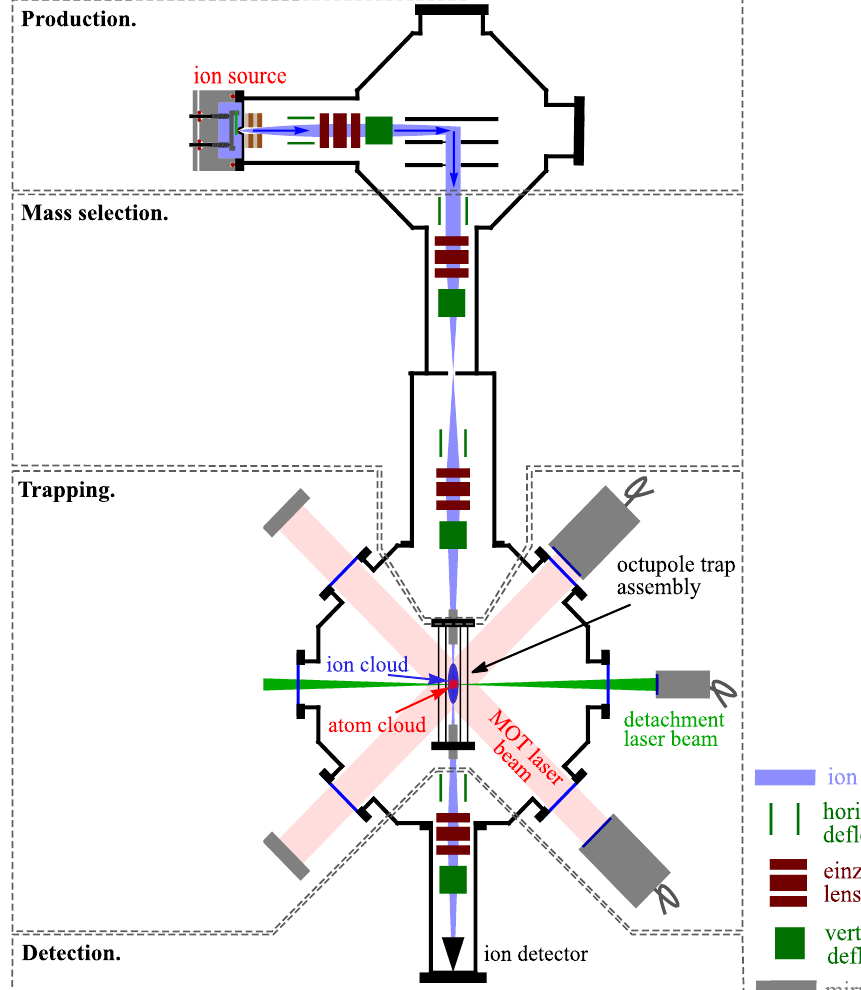
Figure 1. Schematic representation of the Hybrid Atom–Ion Trap (HAI-trap). The ions are produced via a plasma discharge in a pulsed molecular beam and are then guided towards a Wiley–McLaren time-of-flight spectrometer, where the ions are separated according to their mass-to-charge ratio. The ion beam is then guided into the trap, and the entrance endcap is switched to mass-select the desired species. Subsequently, the ions can be overlapped with a cloud of laser-cooled atoms to study atom–ion interactions, or a detachment laser beam can be shone onto the ion cloud for photodetachment tomography. Finally, the ions are extracted via the hollow endcap onto a detector that records the ions’ arrival